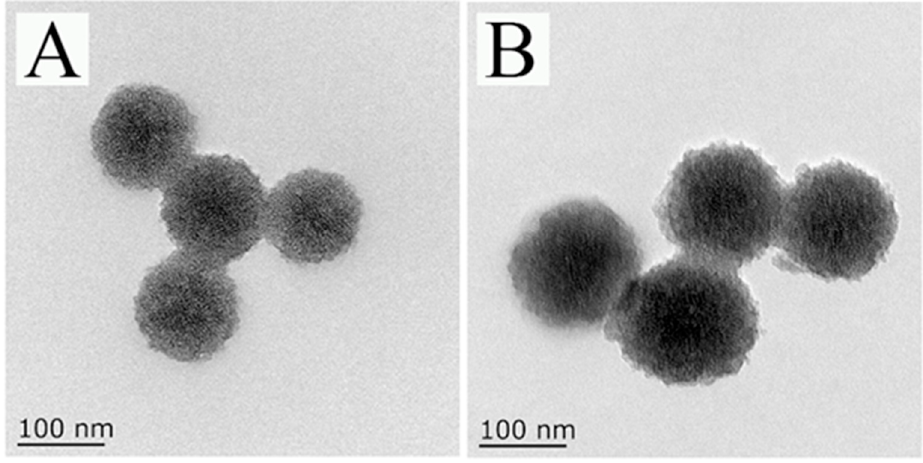
Figure 2. The TEM images of MSNs-NH 2 ( A ) and 4-ATP@MSNs-NH 2 ( B ). MSNs-NH 2 , 4-ATP and 4-ATP@MSNs-NH 2 were further characterized by FTIR. As shown in Figure 3A, MSNs-NH 2 (black line) exhibited four characteristic peaks at 460 cm − 1 , 800 cm − 1 , 1060 cm − 1 , and 1634 cm − 1 , among which 1060 cm − 1 and 800 cm − 1 corresponded to the asymmetric and symmetric tensile vibration peaks of Si–O–Si, 460 cm − 1 corresponded to O– Si–O bending, and 1634 cm − 1 corresponded to –NH 2 bending vibration, indicating success- ful modification of the amino groups on MSNs. When MSNs-NH 2 was loaded with 4-ATP (red line), the characteristic peaks of MSNs-NH 2 were retained, and the same peaks as that of 4-ATP (blue line) appeared at 1492 cm − 1 and 1593 cm − 1 , which belonged to the aroma-